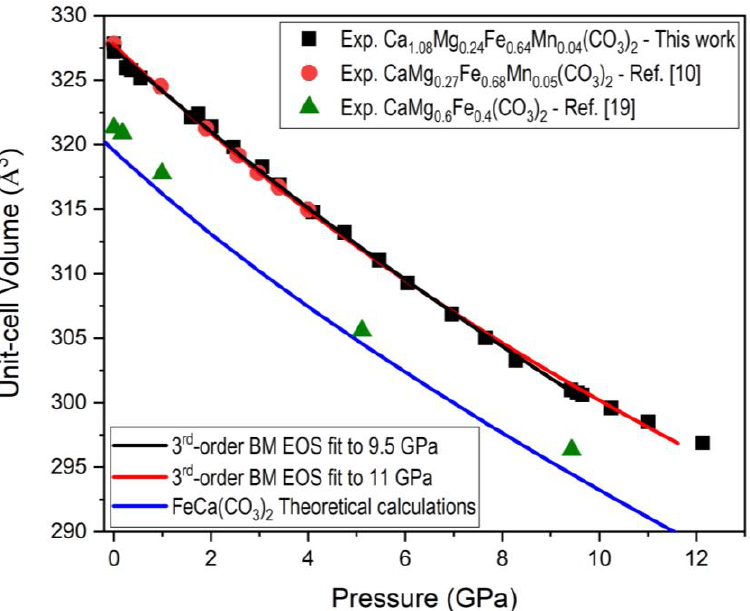
Figure 3. Pressure–volume data per unit cell. Black squares, red circles, and green triangles refer to our Ca 1.08(6) Mg 0.24(2) Fe 0.64(4) Mn 0.04(1) (CO 3 ) 2 experimental (Exp.) data and the reported data by Ross and Reeder (CaMg 0.27 Fe 0.68 Mn 0.05 (CO 3 ) 2 ) [10] and Merlini et al. (CaMg 0.6 Fe 0.4 (CO 3 ) 2 ) [19], respectively. The black and red lines represent the fits of our room-temperature experimental data with a third-order Birch−Murnaghan EOS in the quasi-hydrostatic pressure range and up to 11 GPa, to be compared with the theoretically calculated P – V curve for pure CaFe(CO 3 ) 2 ankerite (blue line).